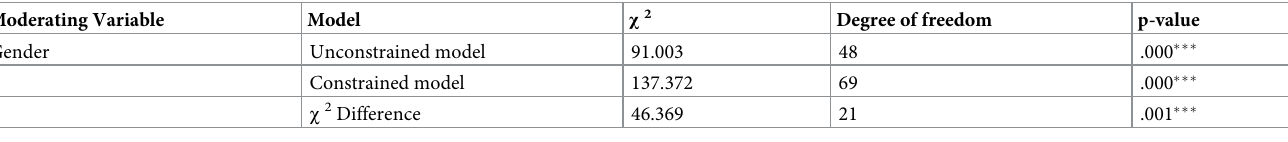
Table 5. Chi-square difference